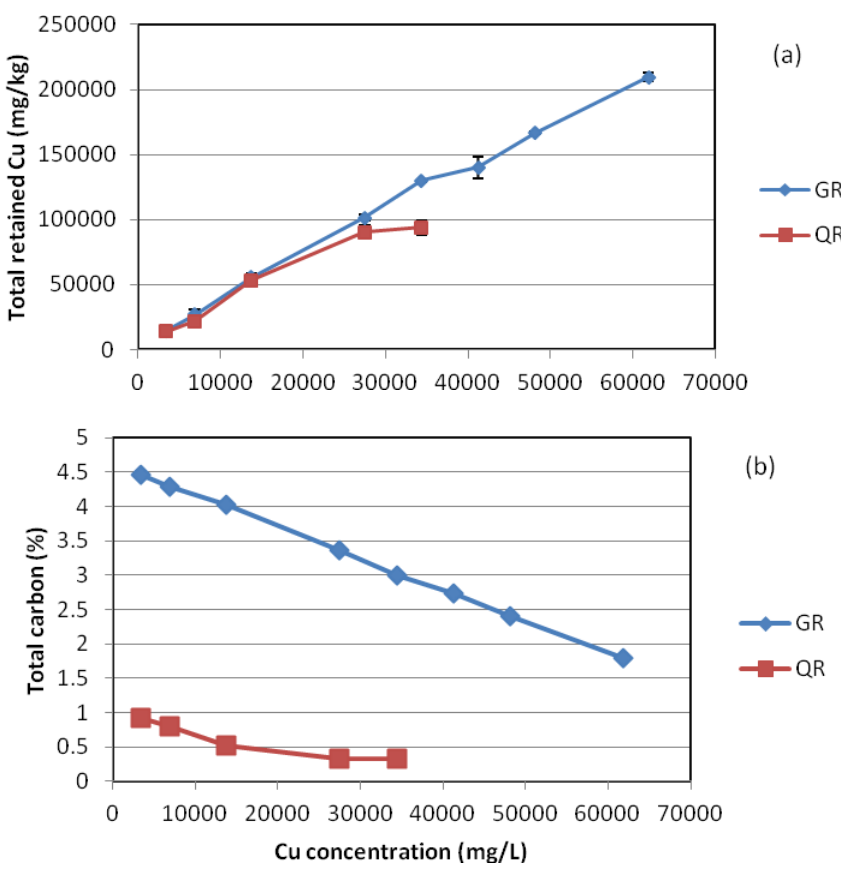
for the two tested red mud 2